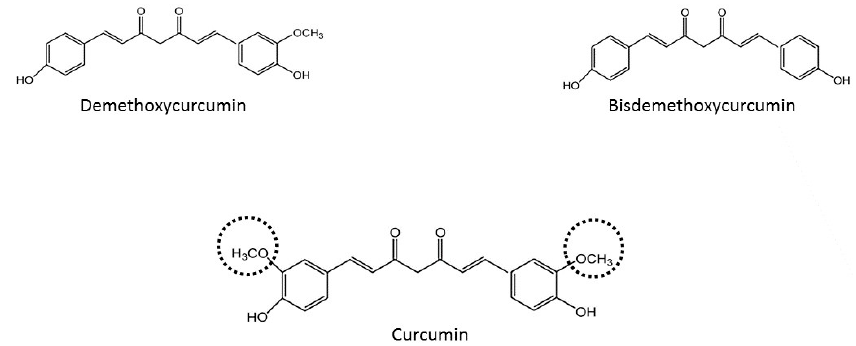
Figure 1. Chemical structures of curcuminoids (methoxy groups in curcumin are shown by discontinuous